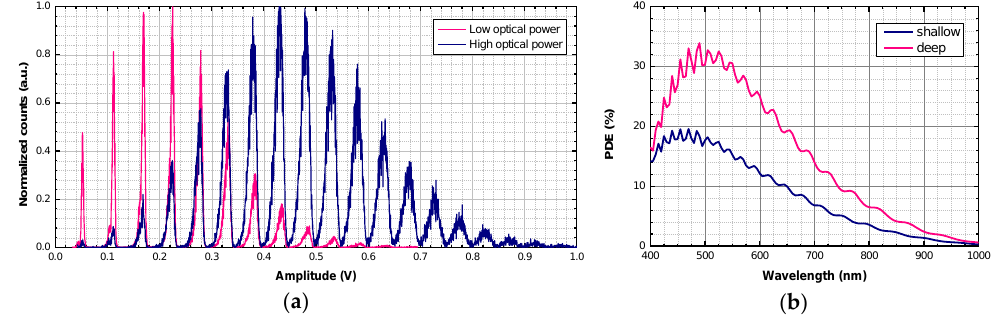
Figure 3. ( a ) Pulse amplitude histogram for a shallow SiPM at 5 V excess bias under pulsed illumination; ( b ) PDE vs. wavelength of the two developed SiPMs at 5 V excess bias (FF included).